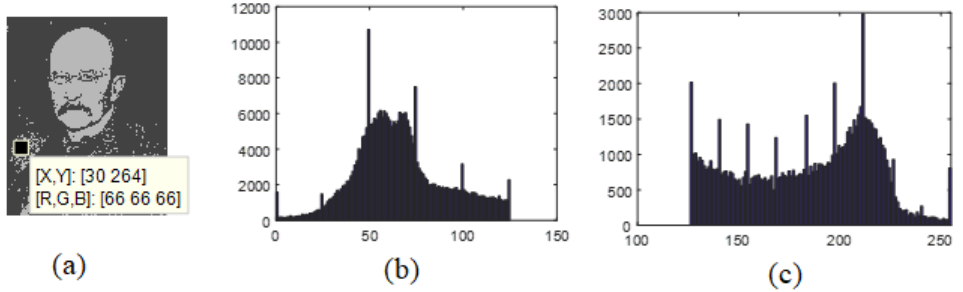
Figure 4. ( a ) Decompression of the image of Max Planck compressed using 2-FCM. ( b ) Histogram of group 1 pixels obtained using 2-FCM (center 1 = 63.75), and ( c ) histogram of group 2 pixels obtained using 2-FCM (center 2 = 186.53).